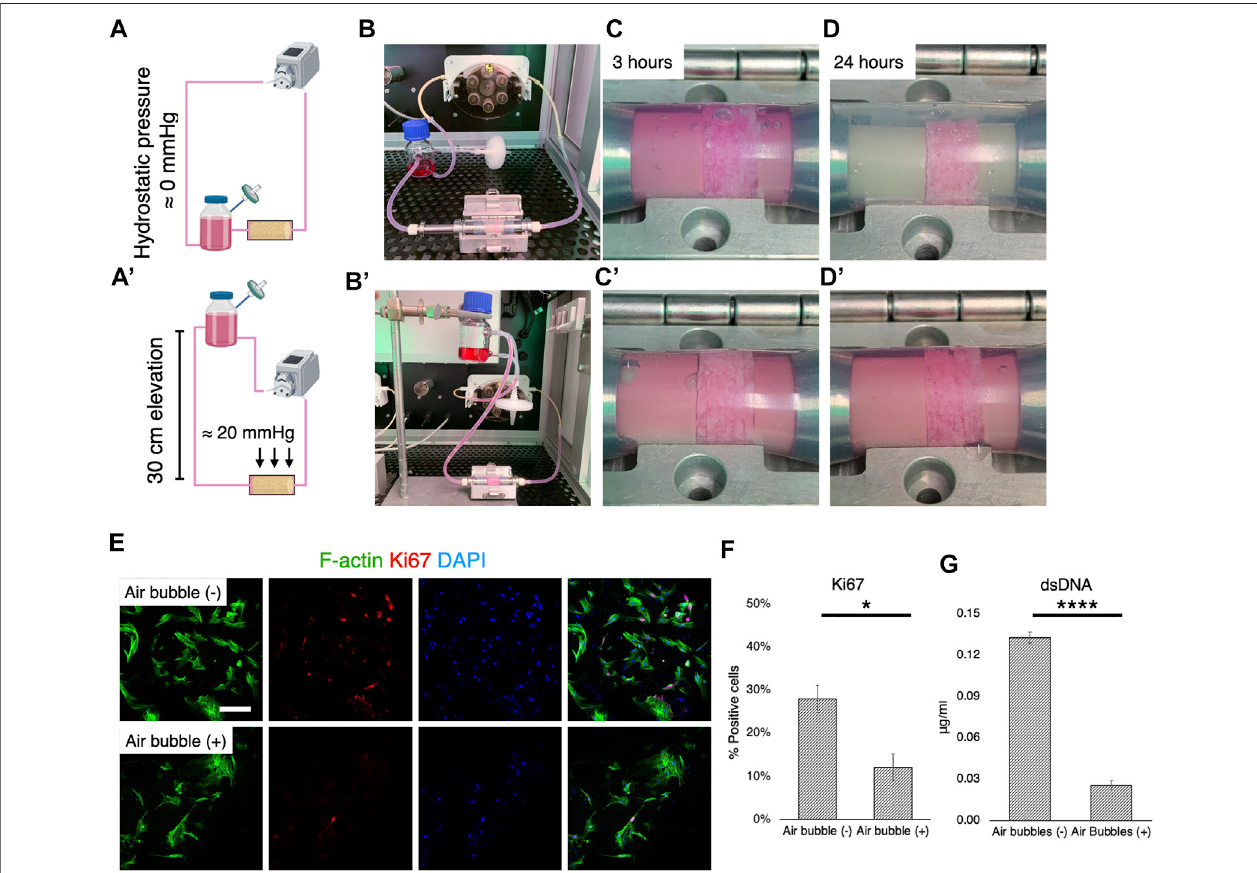
FIGURE 5 | Cell growth deterioration due to air bubbles and suppression. (A-B, A 9 -B 9 ) Schematic illustrations and optical pictures of experimental con fi guration. The elevation of the medium reservoir by 30 cm corresponded to 20 mmHg hydrostatic pressure. (C-D, C 9 -D 9 ) . With the experimental con fi guration, air bubbles were vigorously generated, mostly due to hydrophobic porous scaffolds and medium agitation in the scaffold chamber. This was effectively prevented by the application of hydrostatic pressure at 20 mmHg. (E,F) Immuno fl uorescence images and quanti fi cation of a proliferation marker, Ki67, showed that cell proliferation was signi fi cantlyaffectedundertheenvironmentwithairbubbles. (G) Quanti fi cationofdoublestrandDNAcon fi rmedtheinhibitionofcellgrowthbyairbubblesintheperfusion system. Scale bar: 100 μ m. * p < 0.05, **** p <